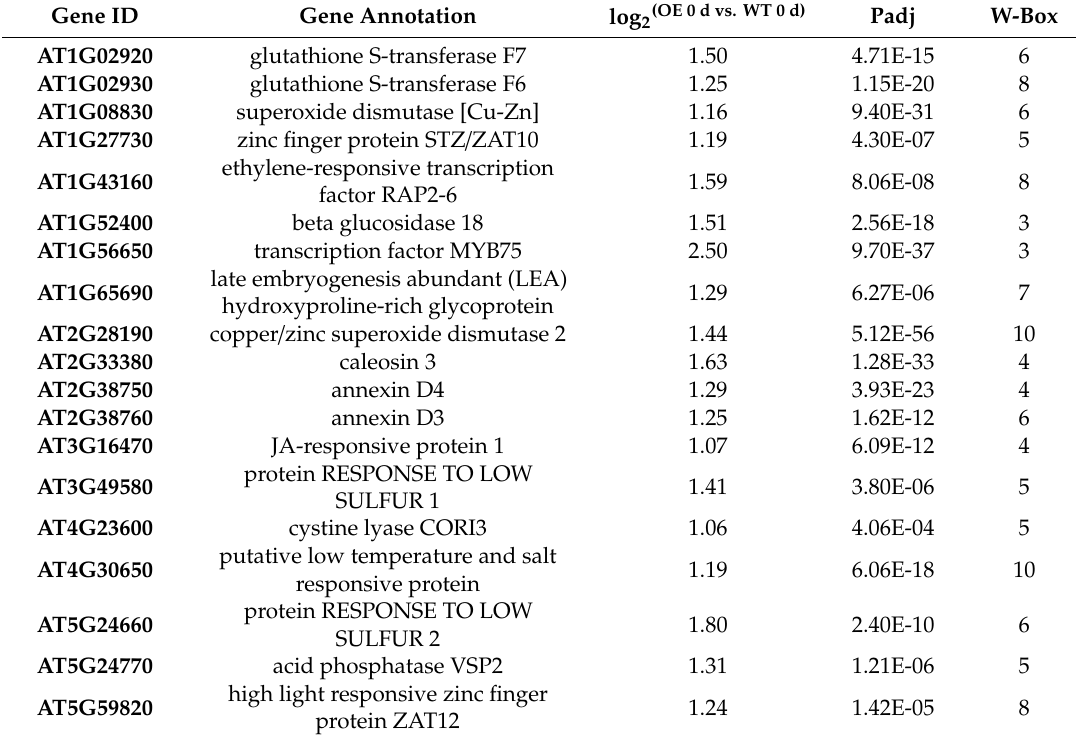
Table 1. The 19 di ff erentially expressed genes (DEGs) involved in salt stress and osmotic stress processes based on Gene Ontology (GO) enrichment